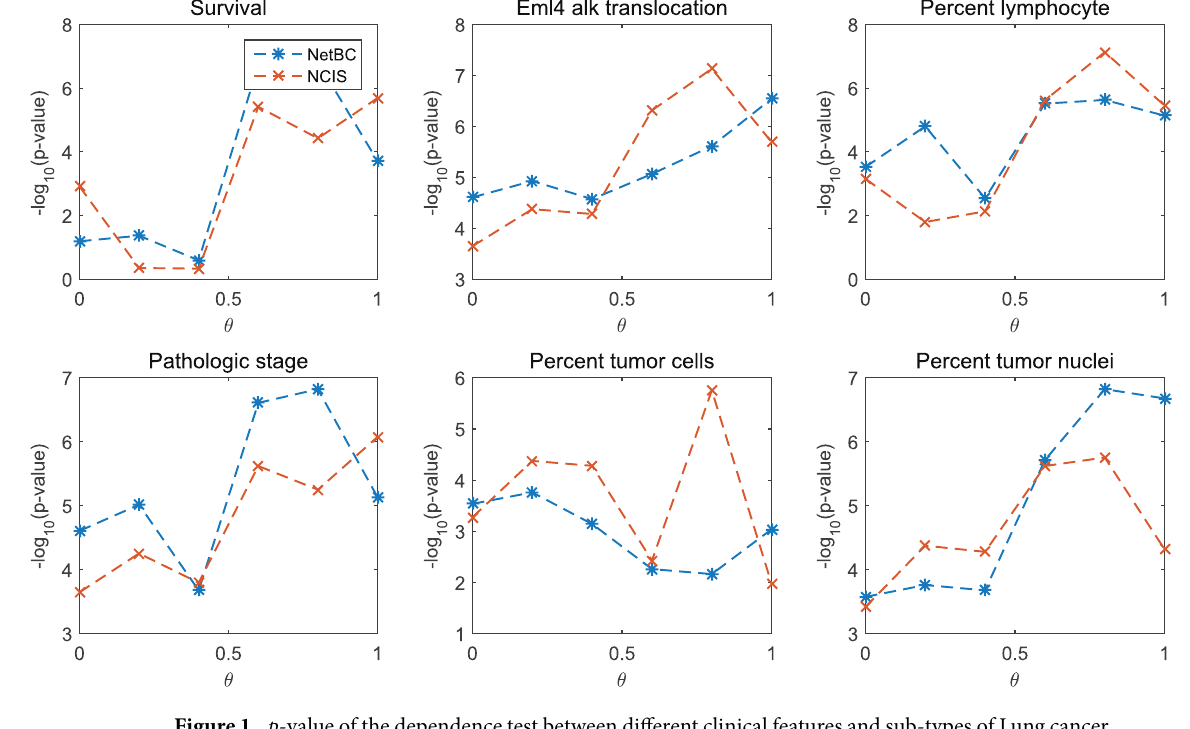
Figure 1. p -value of the dependence test between different clinical features and sub-types of Lung cancer discovered by NetBC (or NCIS) under different input values of θ For the survival time, we use logrank test. For the eml4 alk translocation performed, percent lymphocyte infiltration, percent tumor nuclei, and percent tumor nuclei, we use the Chi-squared test. The p value is adjusted by Benjamini & Hochberg method. Larger − log 10 ( p - value) means better performance.